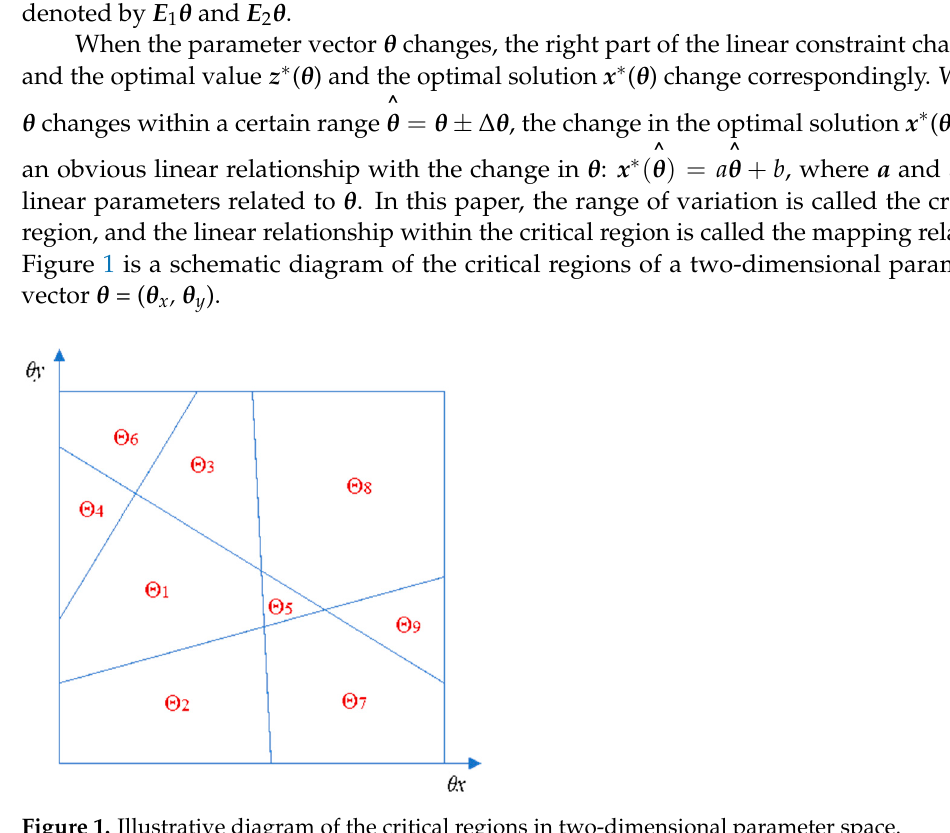
Figure 1. Illustrative diagram of the critical regions in two-dimensional parameter space.